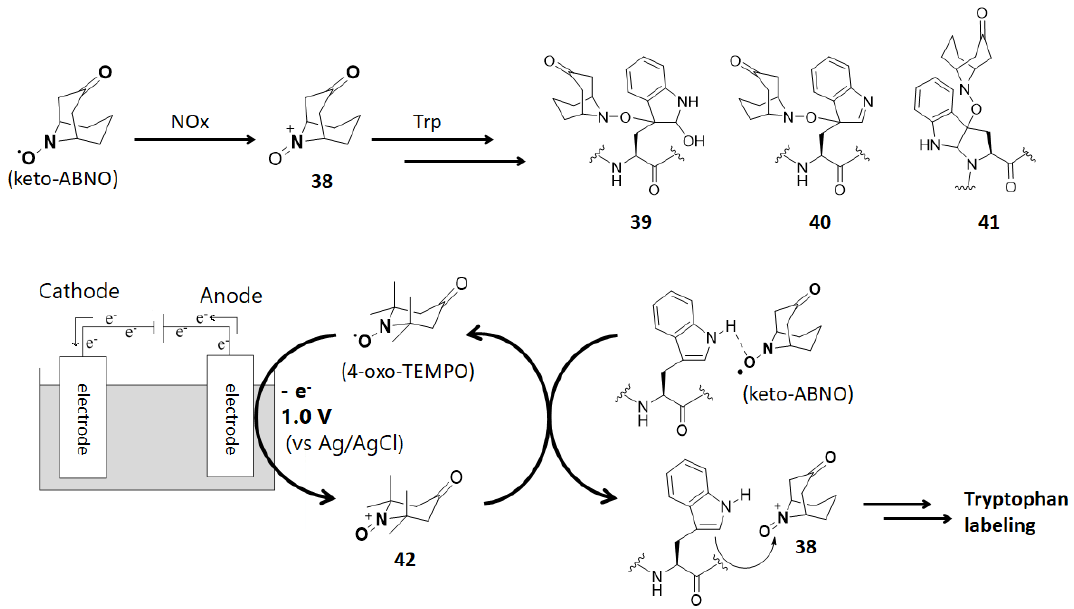
Figure 12. Tryptophan labeling with keto-ABNO and the electrochemical activation of tryptophan labeling.